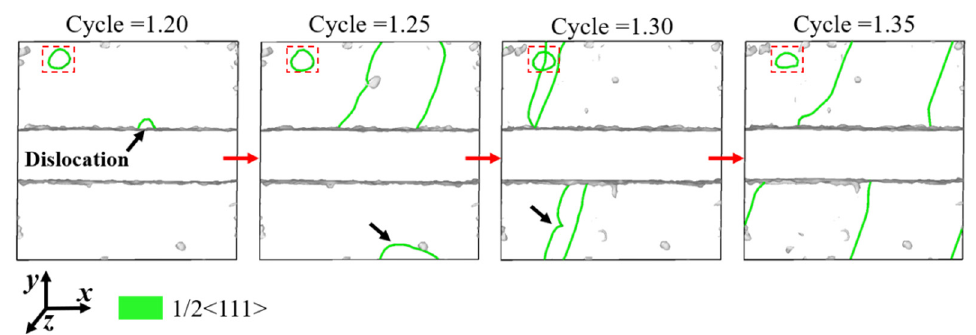
Figure 11. Nucleation and grow process of a 1/2<111> dislocation on the interface when γ 2 is applied along the y -axis. The whole process is contained in the second cycle. A dislocation loop exists in the red dotted box.